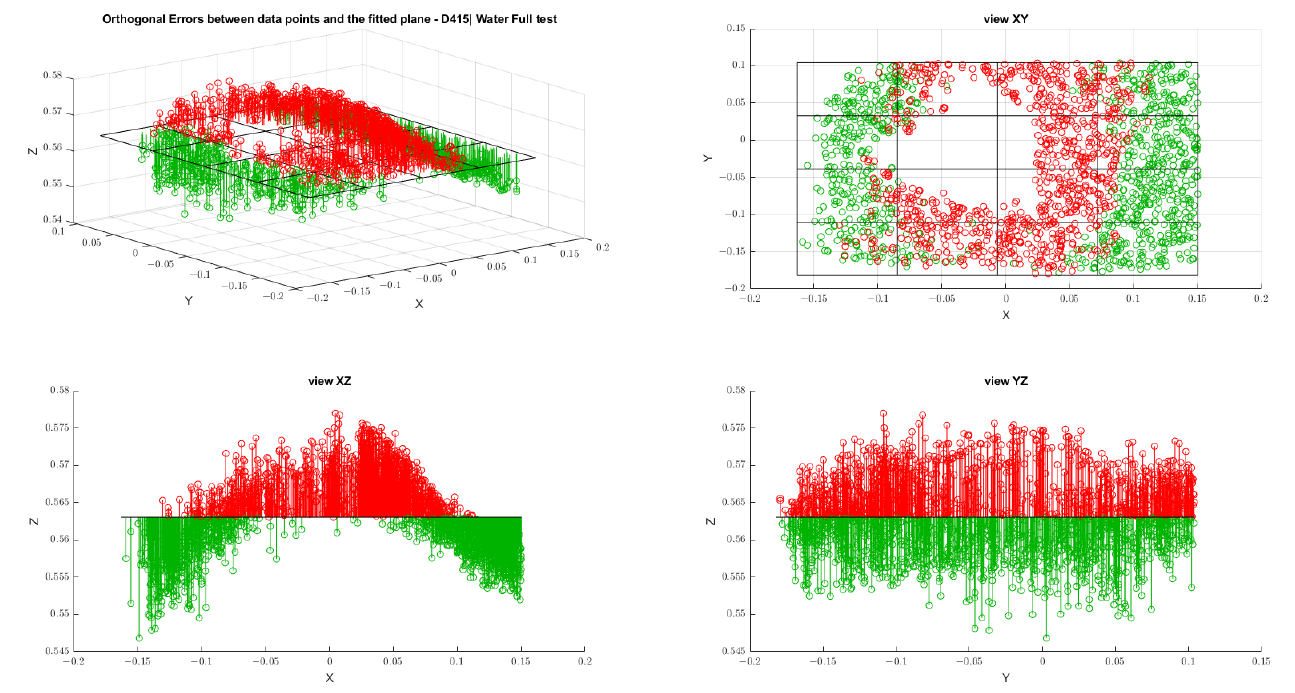
Figure A3. Results of orthogonal errors for the D415 camera referring to the water full test.